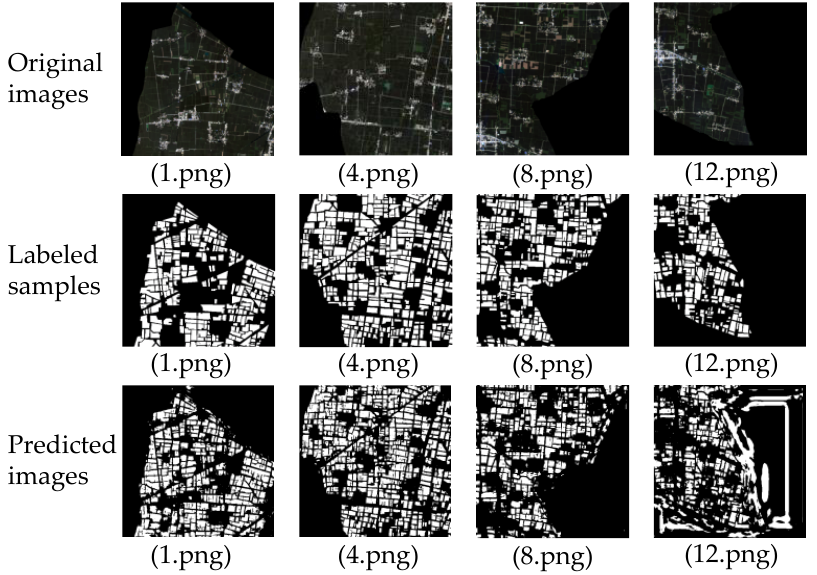
Figure 7. The test results under the 256 × 256 px cropping size.